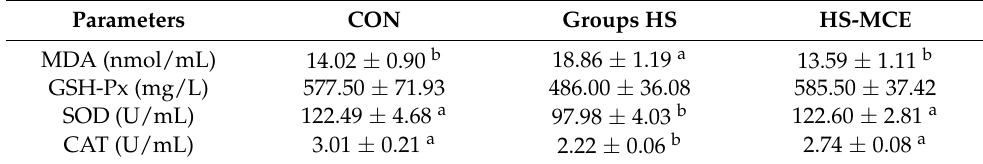
Table 2. Serum of redox status.